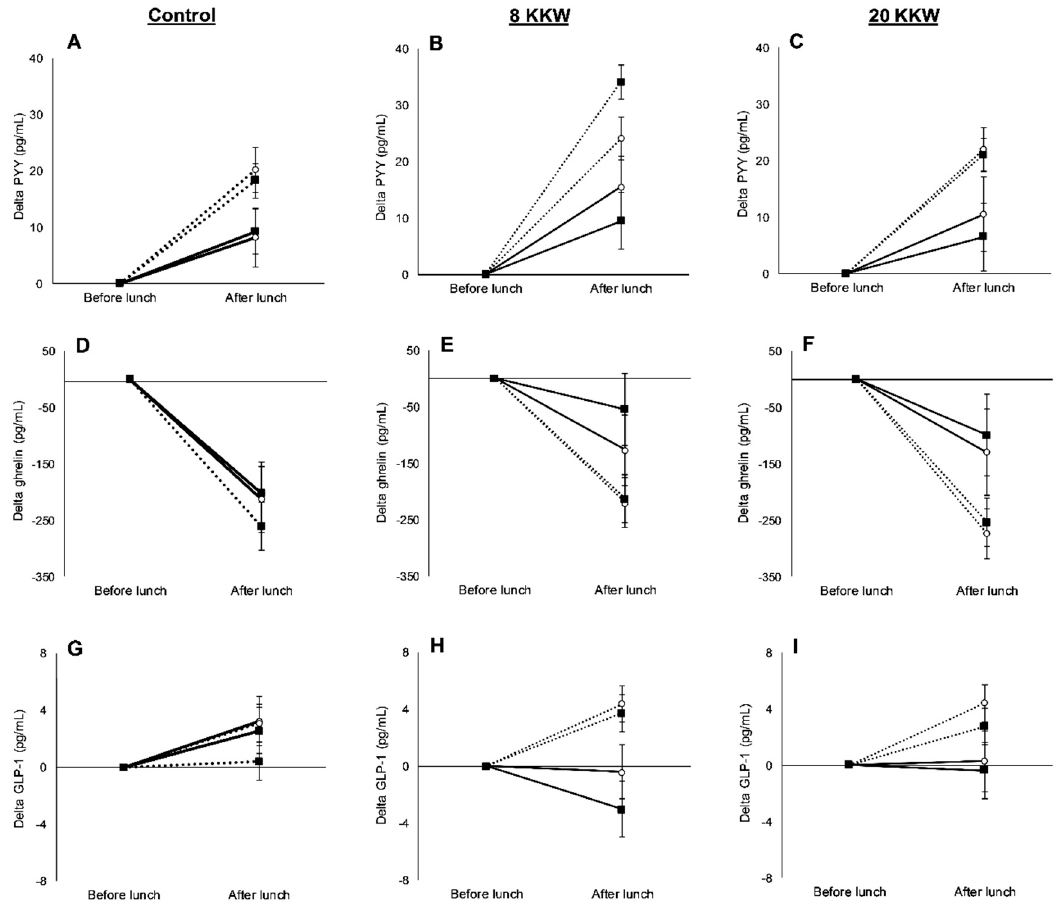
Figure 6. Di ff erences in delta peptide YY (PYY) from before lunch ( A – C ), delta ghrelin from before lunch ( D – F ), and delta glucagon-like-peptide-1 (GLP-1) from before lunch ( G – I ) between African Americans (AAs; solid line) and Whites (dashed line) at baseline (open circle) and after the exercise intervention (dark square) in the control, 8 KKW, and the 20 KKW groups. No significant di ff erences between races and group were observed for change score, as examined by a two-way unpaired general linear model, controlling for baseline ( p ≥ 0.05). Values are means ± SEM.